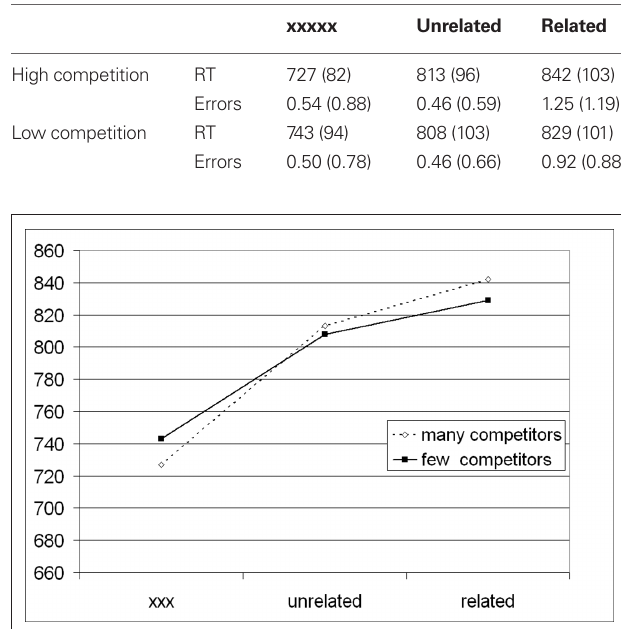
Table 4 | Mean naming latencies and errors across conditions (in ms, SD in